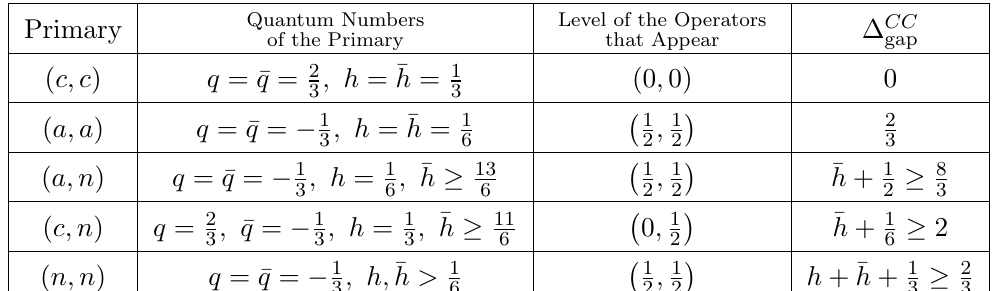
-BPS primaries 4